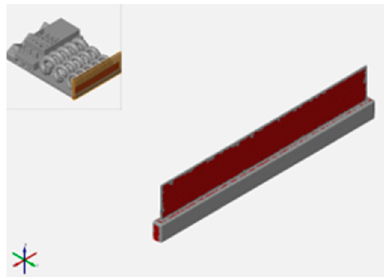
Figure 10. View of alignment on the thin wall.